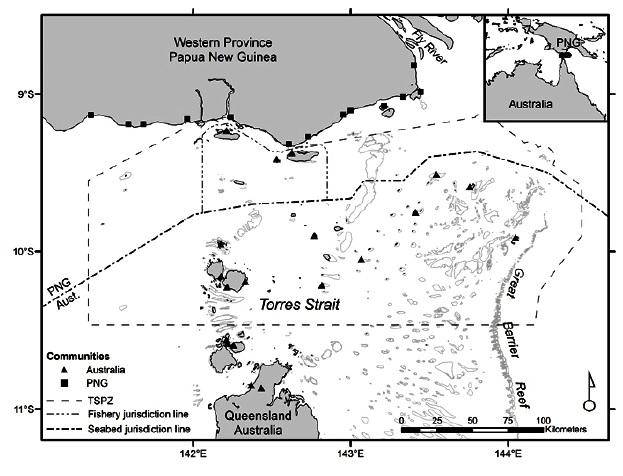
Fig. 1 . The Torres Strait, showing the Torres Strait Protected Zone (TSPZ) established under the Torres Strait Treaty and the location of Australian and Papua New Guinea communities.